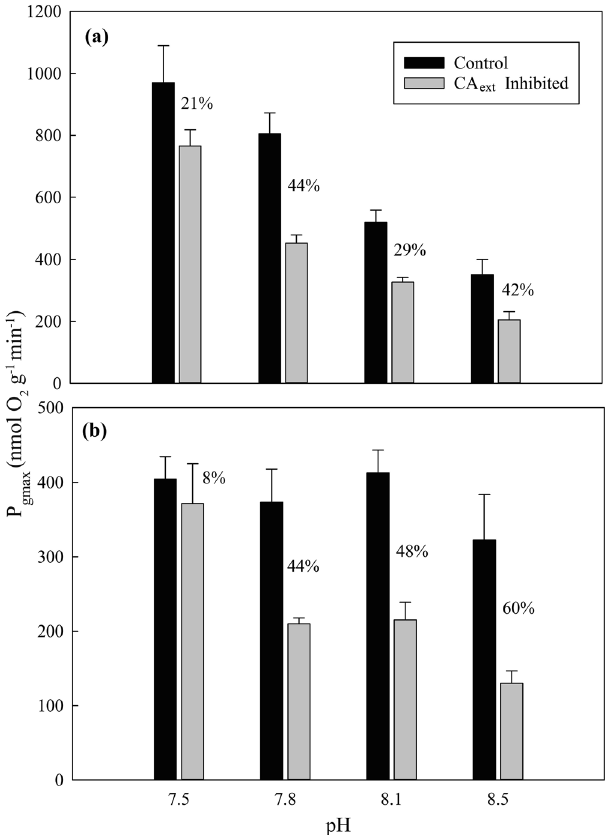
Figure 4. The effect of external carbonic anhydrase (CA ext ) inhibition by acetazolamide (AZ) on maximum photosynthetic rates (P gmax ) for ( a ) Canistrocarpus cervicornis and ( b ) Jania adhaerens at four pH levels. Data are means with SE (n = 7–8). P gmax was calculated from PI curves fit to a hyperbolic tangent equation 39 . Percent differences between control and CA ext inhibited P gmax rates are shown.